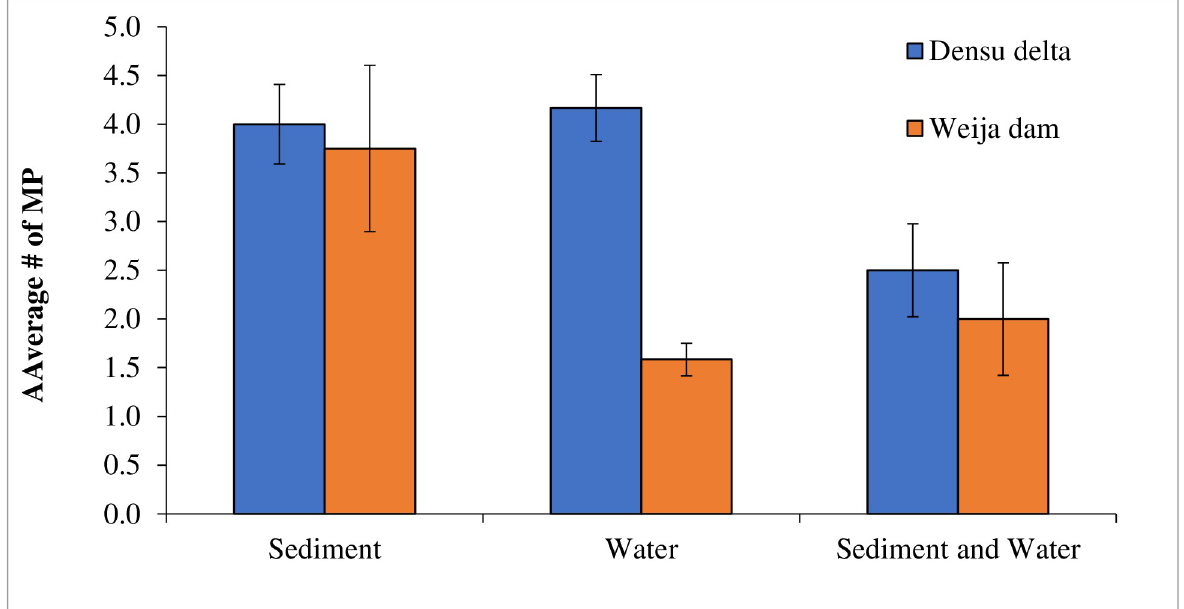
Fig 1. Number of microplastics in sediment and water of the Densu Delta and Weija Dam in Ghana.